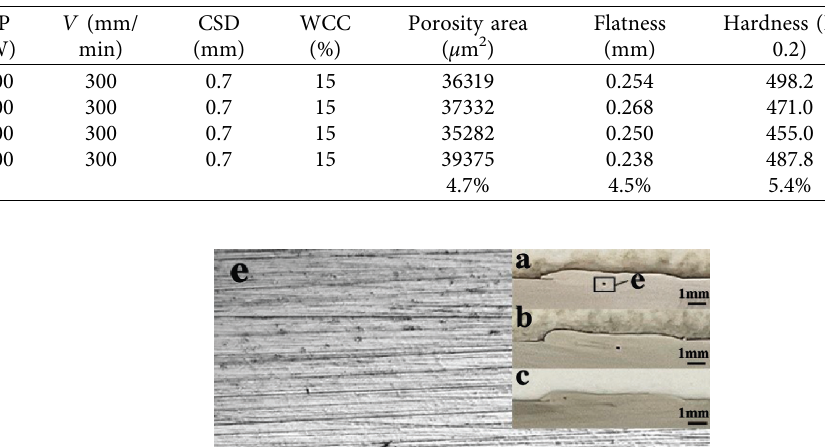
Table 9: Model prediction and validation.